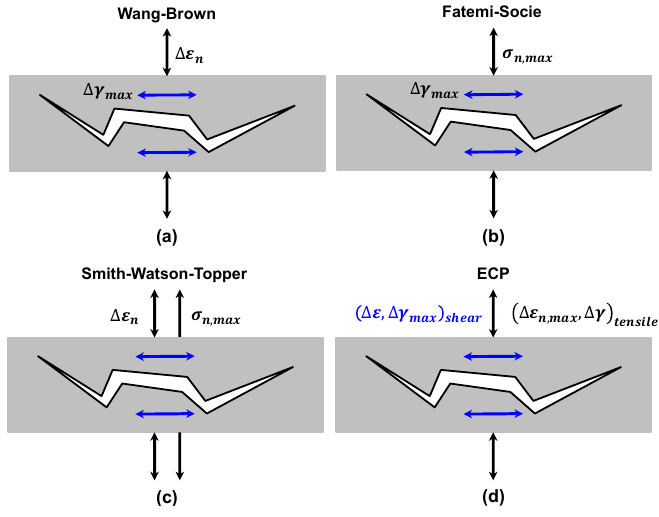
Figure 4. Fatigue fracture mechanisms of the four models.